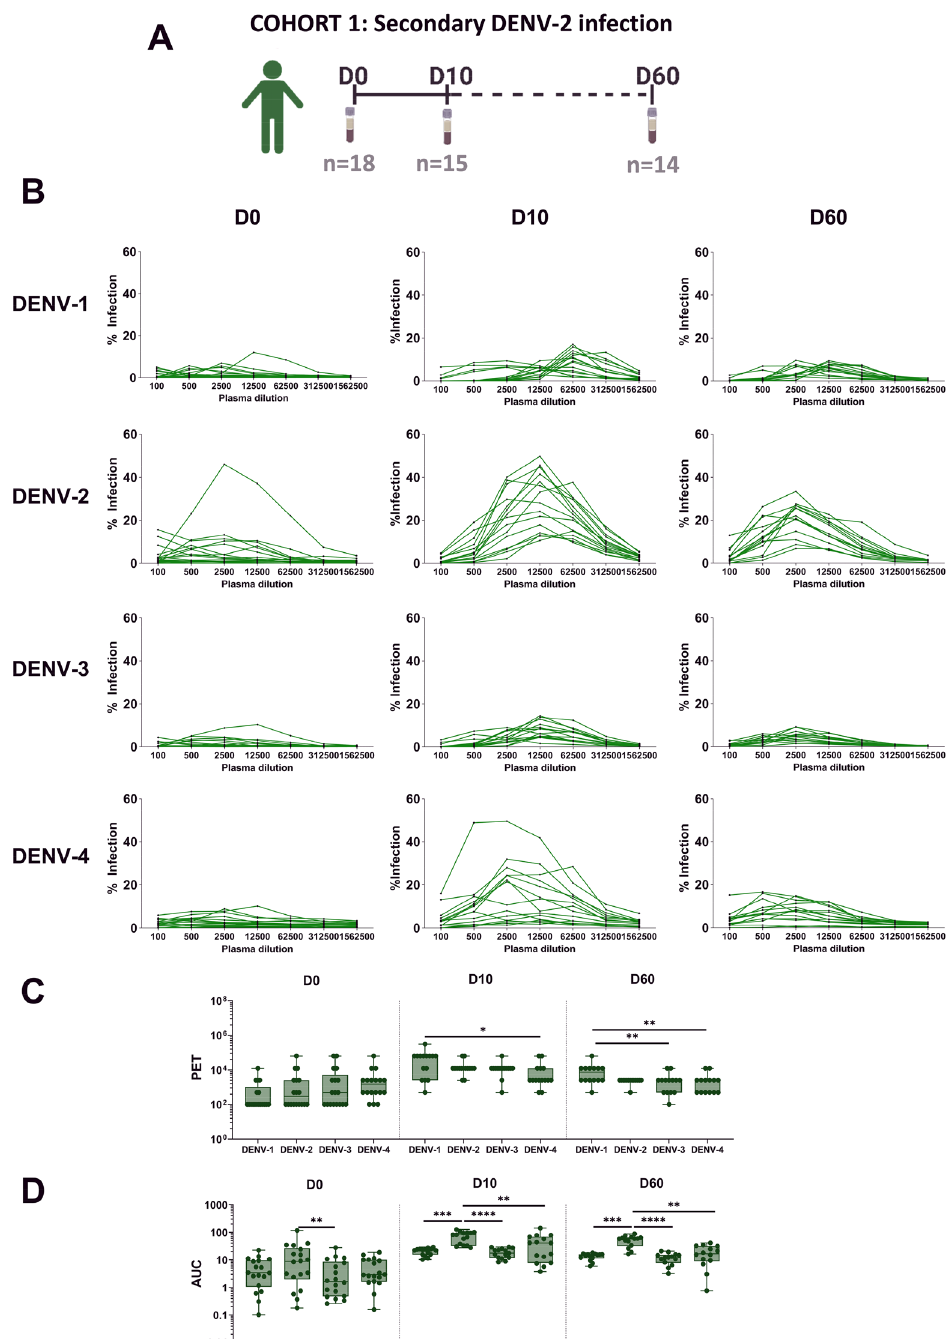
Figure 1. Kinetics of antibody-dependent enhancement (ADE) activity to all four DENV serotypes. Graphical summary of plasma samples collected in cohort 1 ( A ). 18 plasma samples were collected on the day at inclusion (D0, day of laboratory confirmed infection), D10 and D60. There are 12 paired-plasma samples across the 3 time points. Plasma was analyzed in vitro using U937 cells infected with one of the four DENV serotypes (DENV-1 to 4). The percentages of DENV-infected cells in the presence of serial diluted plasma is shown and each line represents an individual plasma sample ( B ). ADE titers are shown as peak of enhancement titer (PET) and area under the curve (AUC) generated from each plasma ( C, D ). Each point in the box plot represents an individual plasma sample. Whiskers show max, min, median values and the interquartile range beyond the 25th and 75th percentiles. Friedman test was used to compare multiple groups in each time point ( P < 0.05; ** P < 0.01; *** P < 0.001; **** P <